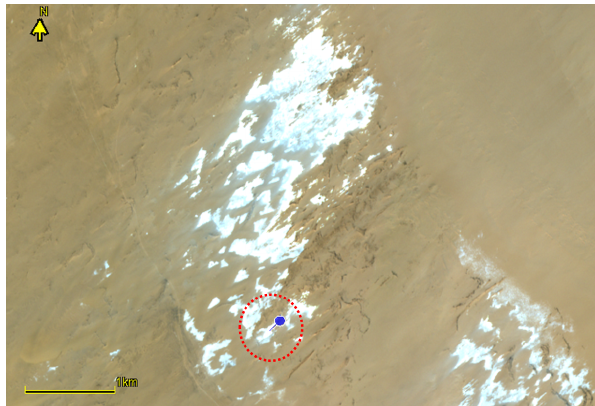
Figure A1. ©Copernicus data (2019). Sentinel-2 natural colour composite showing a diatomite palaeolake in the Bodélé Depression re- gion, Chad, identified as a dust source. This source emitted dust on 23 December 2015. The location of the pin is latitude 17.4875, longi- tude 19.4845. A 750m buffer is included in red. Background: European Space Agency Copernicus Sentinel-2 data 2018. Sentinel-2 data are provided under the terms and conditions prescribed by the European Commission’s Copernicus Programme. For detailed information on the data policy, appropriate usage, and citation of Sentinel data, please see: https://scihub.copernicus.eu/twiki/pub/SciHubWebPortal/